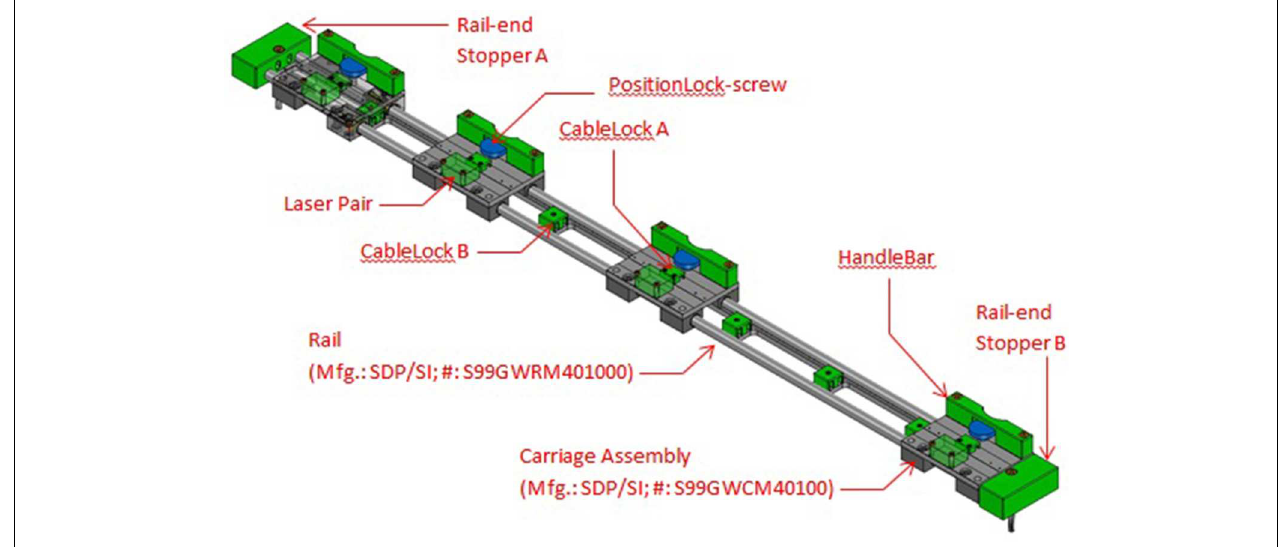
FIGURE 3 | Details of sensor carriage assembly showing the four carriages for the four sensor beams. The carriages may be repositioned to different locations and locked in place.